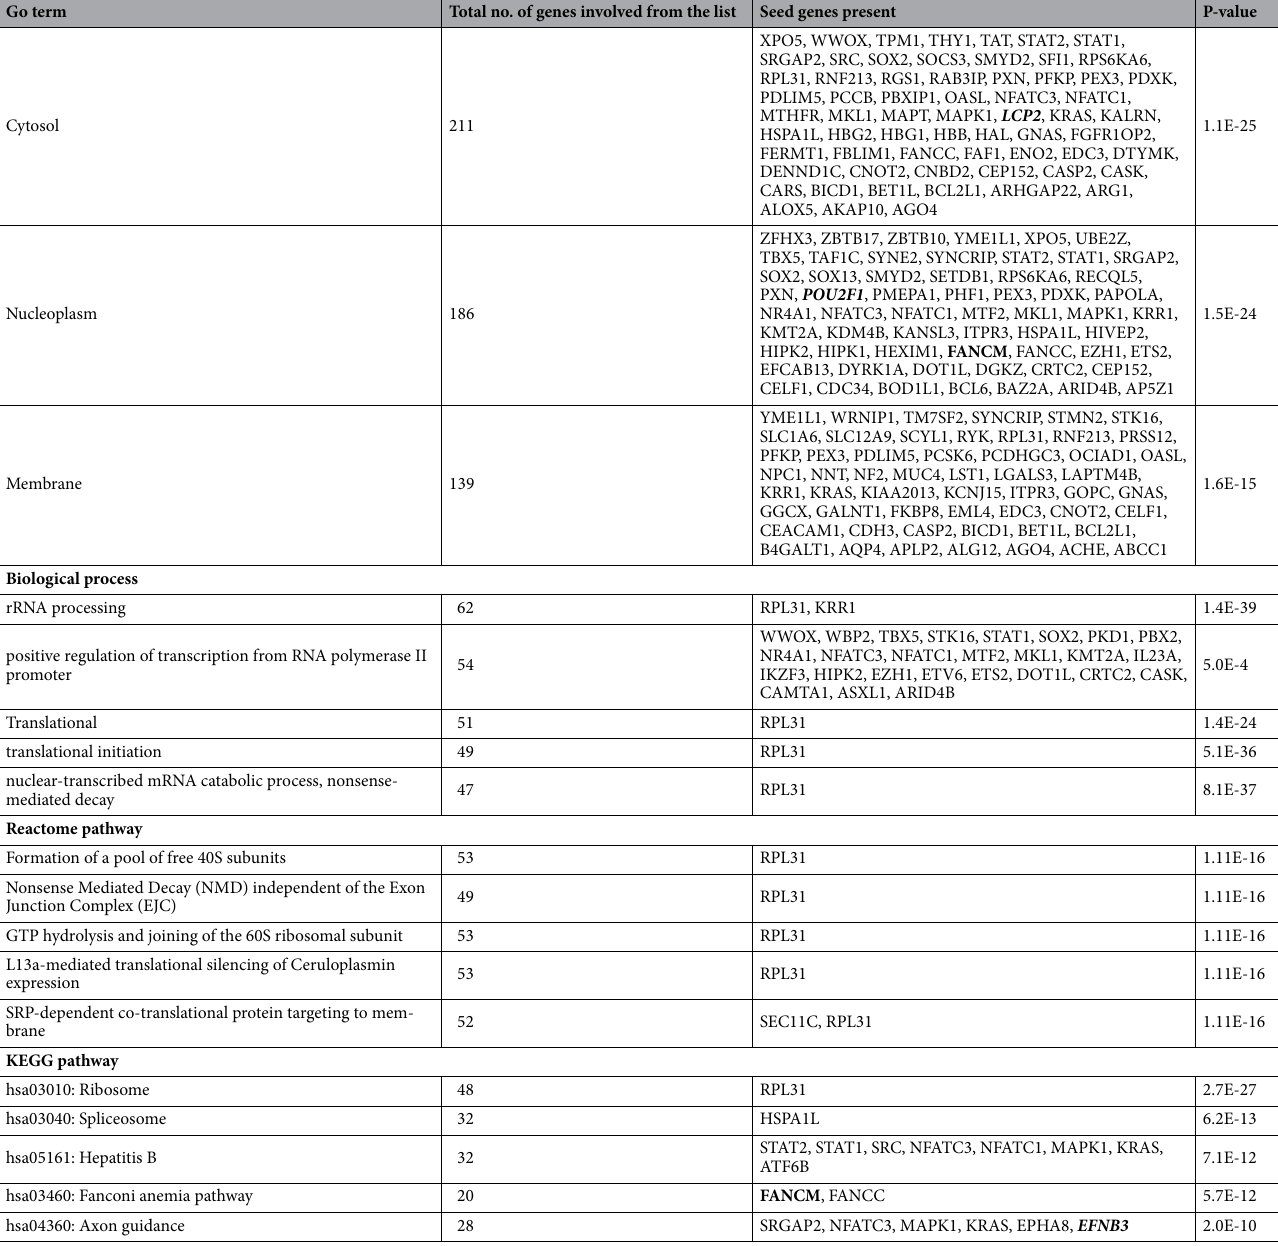
Table 3. The gene ontology and pathway enrichment of DEGs of TS, signature genes of T2DM and RM and their interacting partners. Key genes are bold and italicised and signature genes are